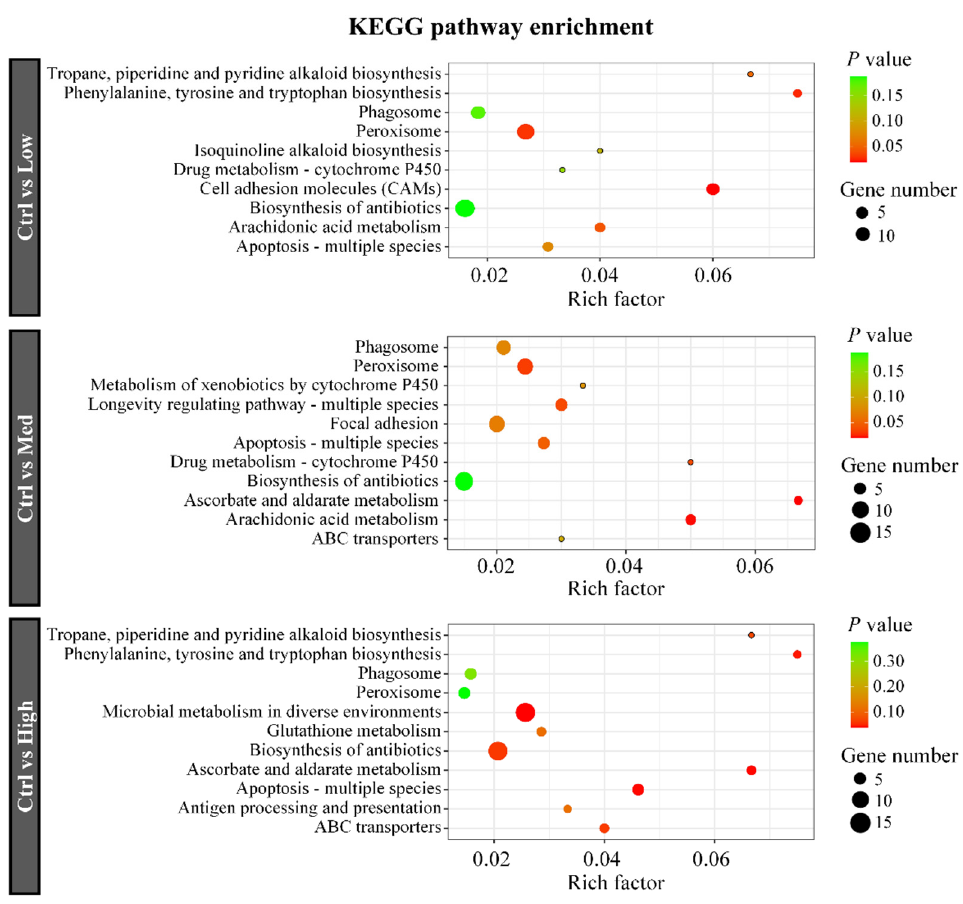
Figure 4. KEGG enrichments of the DEGs after treatment with different concentrations of Hg. The horizontal axis denotes the rich factor while the vertical axis denotes pathways. Color shades represent different p -values while dot sizes denote the number of DEGs. A larger dot indicates more DEGs. Ctrl: 0 μ g/L Hg 2+ ; Low: 8.75 μ g/L Hg 2+ ; Med: 21.875 μ g/L Hg 2+ ; High: 43.75 μ g/L Hg 2+ .